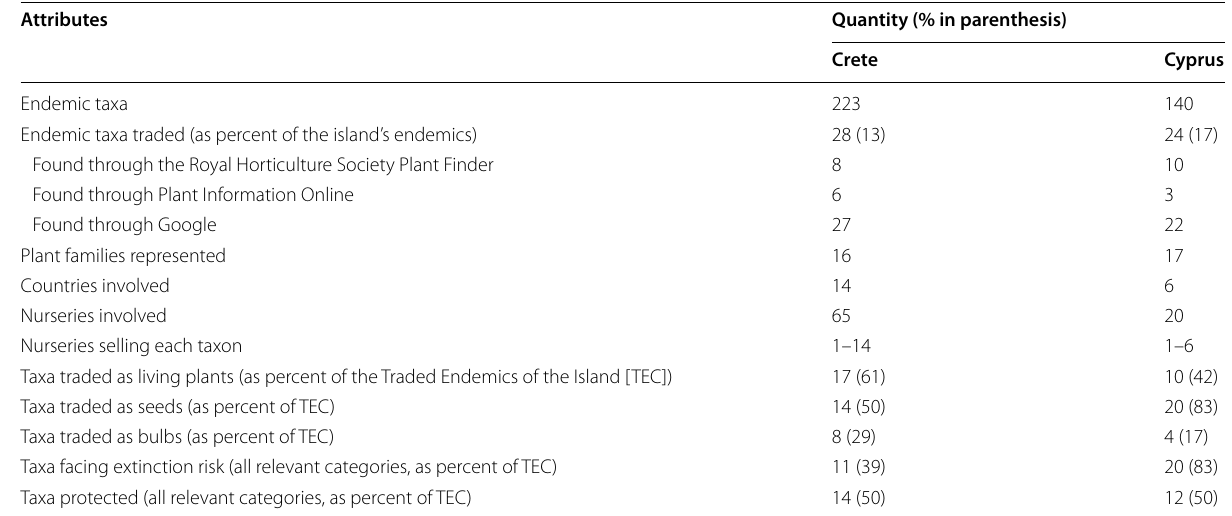
Table 1 Summary results regarding the quantitative aspects for the electronic trade of the endemic taxa (species and subspecies) of Crete (Greece) and Cyprus [16]